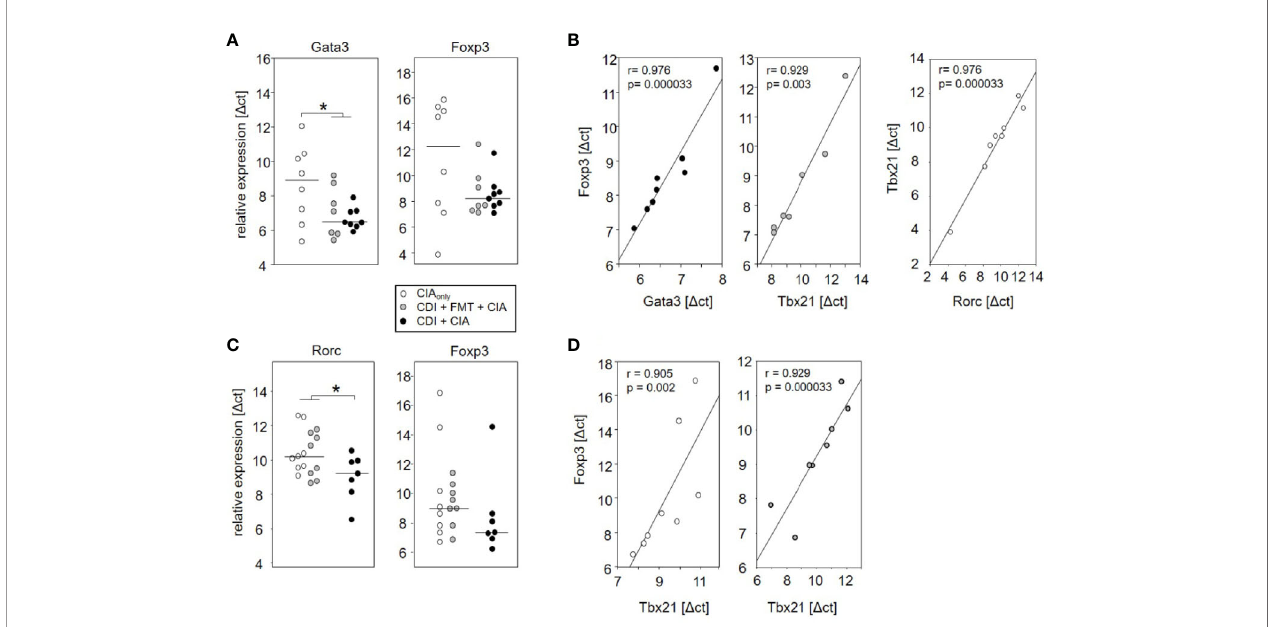
FIGURE 6 | Spontaneous clearance of VPI 10463 infection led to mesenteric but not inguinal T reg polarization. Dot plots show the differential expression of subset- speci fi c transcription factors in the mesenteric (A) and inguinal (C) lymph nodes relative to Gapdh. The p-values resulting from t-test were 0.018 for A and 0.0325 for (B) Linear regression analyses indicate correlations among the expression of transcription factors (B) and between Gata3 expression and arthritis scores (D) . Calculations were performed via Spearman rank correlation analyses. Each dot represents an individual mouse.